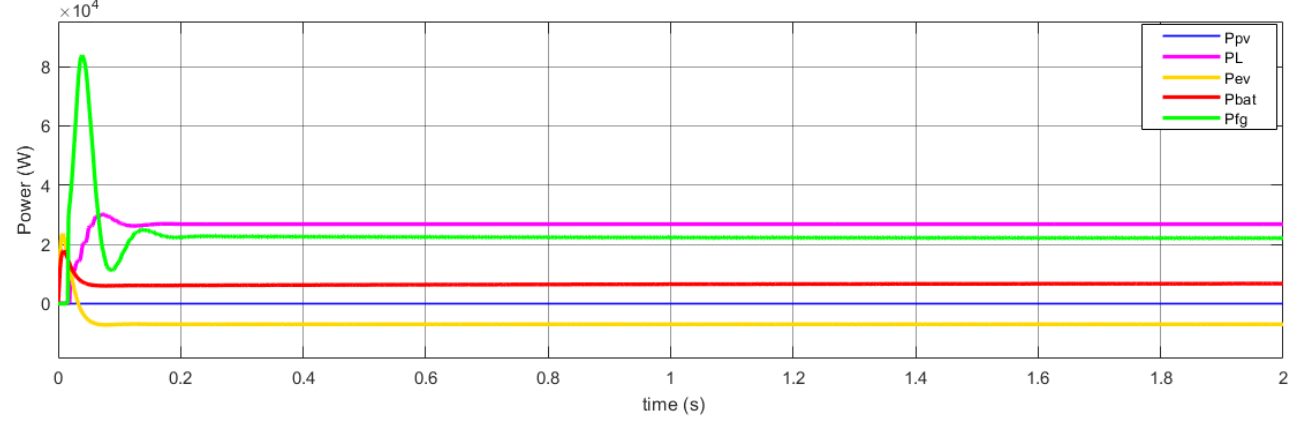
Figure 11. EV and ba tt ery discharging to meet the demand of the loads. ( a ) EV SOC. ( b ) storage